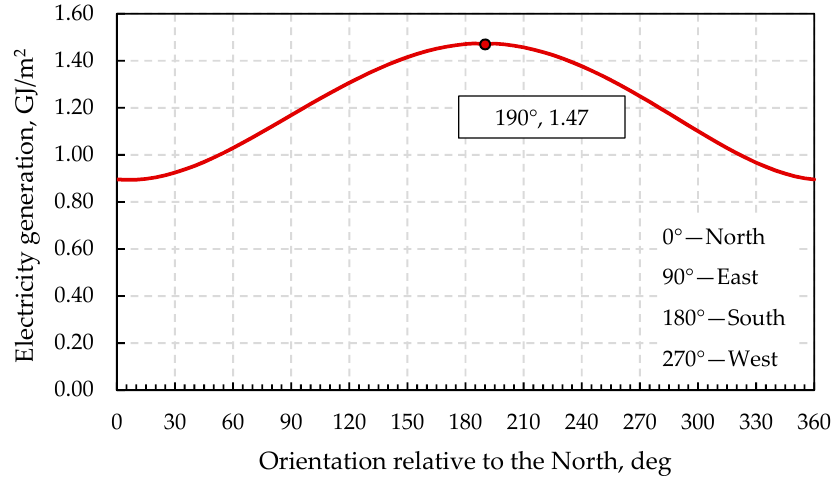
Figure 11. Effect of orientation of PV on electricity generation potential.